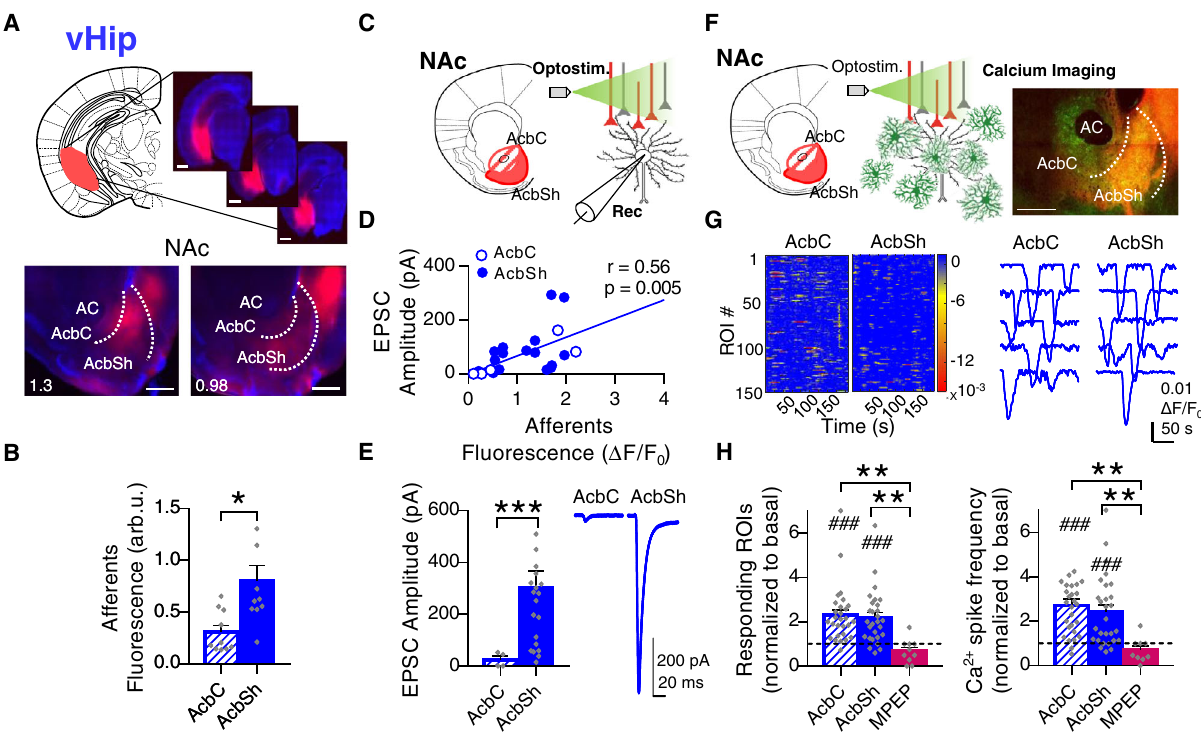
Fig. 6 | Pathway-speci fi c nucleus accumbens (NAc) astrocyte activity in responsetoventralhippocampus(vHip)afferents.A Schemeandrepresentative slices showing opsin expression after AAV injection into the vHip (top; scale bar=1mm) and their tdTom-expressing afferents to the NAc (bottom; scale bar= 500 µ m). B Quanti fi cation of vHip afferents fl uorescence (arb.u.) in accumbens core (AcbC; slashed bar) and accumbens shell (AcbSh; solid bar) (10 infections, 6 mice). Two-tailed unpaired t test Welch-corrected, * P =0.01. C Scheme of NAc neuron ’ s electrophysiological recordings in response to vHip afferent ’ s optosti- mulation. D Positive correlation between NAc neuron ’ s response (pA) and vHip afferents ’ density( Δ F/F 0 intheareaofregister)(23cells,5mice). E EPSCamplitude (pA) quanti fi cation (left) from AcbC (slashed bar; 4 cells, 3 mice) and AcbSh neu- rons(solidbar;21cells,6mice)andrepresentativeEPSCstraces(right)showingthe synaptic neuronal strength triggered by vHip in each subregion. Two-tailed unpaired t test, *** P <0.001. F Scheme of astrocytic Ca 2+ dynamics, monitored by